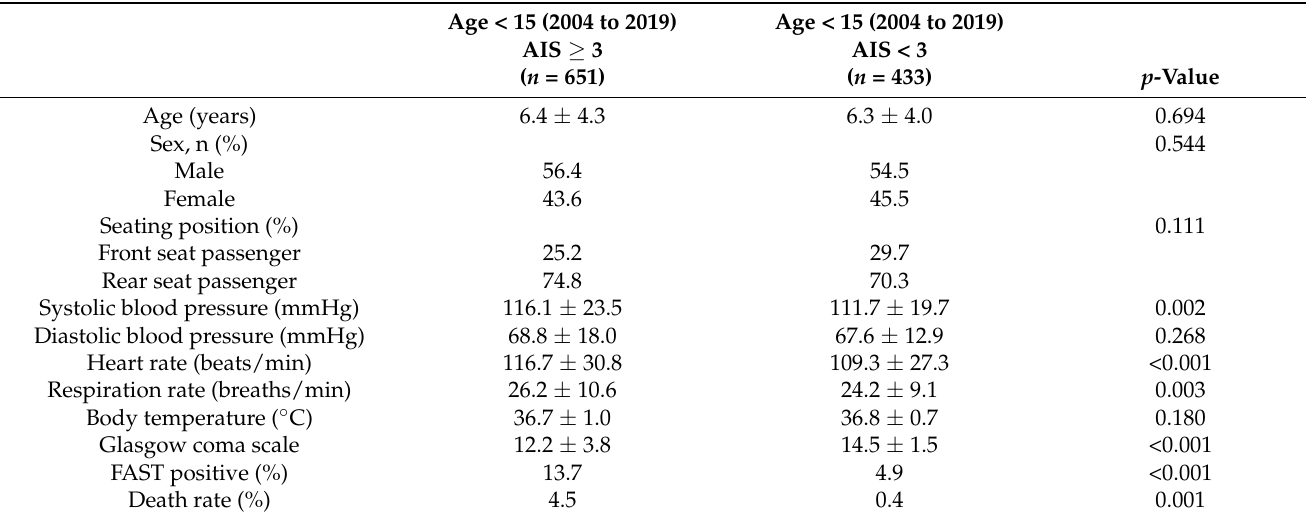
Table 3. Comparison of patients’ characteristics and data at hospital arrival in those aged < 15 years with an AIS score ≥ 3 and those with an AIS score < 3 (2004–2019). FAST: Focused Assessment with Sonography for Trauma.